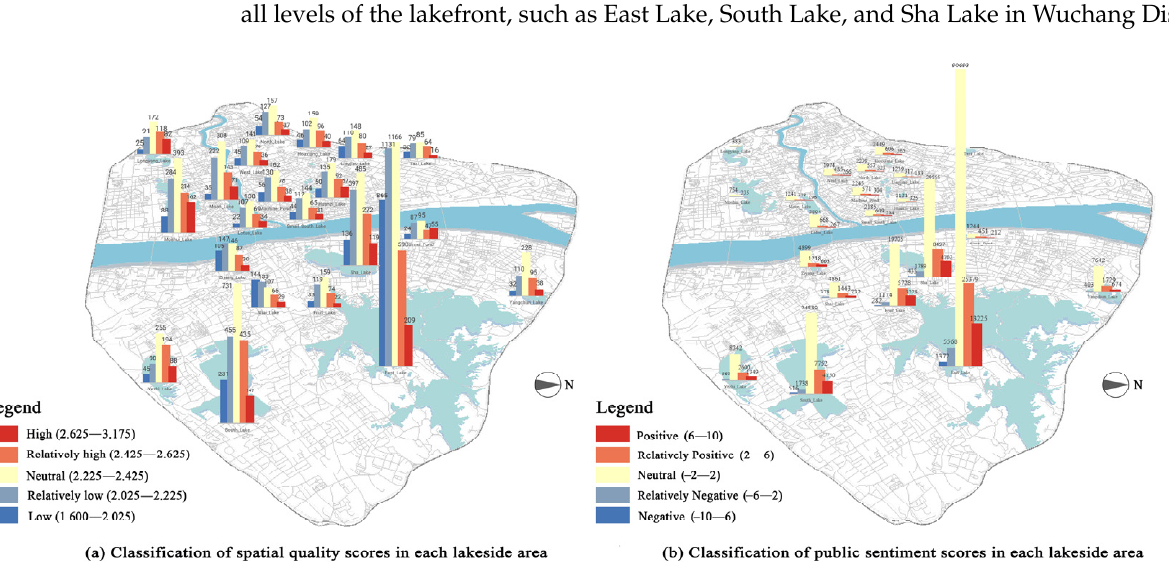
Figure 10. Classification characteristics of spatial quality ( a ) and public mood ( b ) in each lakefront area. The average space quality score and public sentiment score of each lake were calculated separately and compared with the mean scores of the entire study area to explore